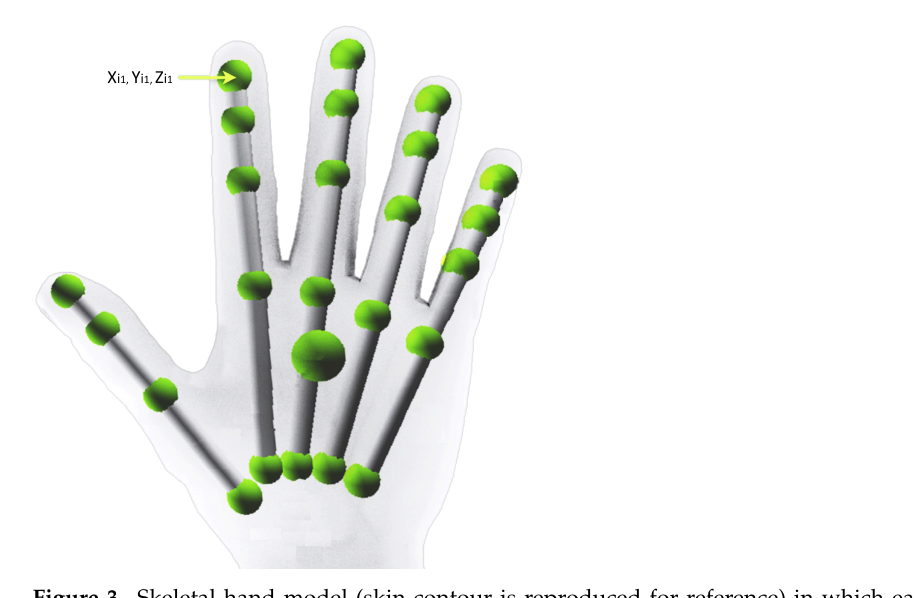
Figure 3. Skeletal hand model (skin contour is reproduced for reference) in which each joint is represented by a green